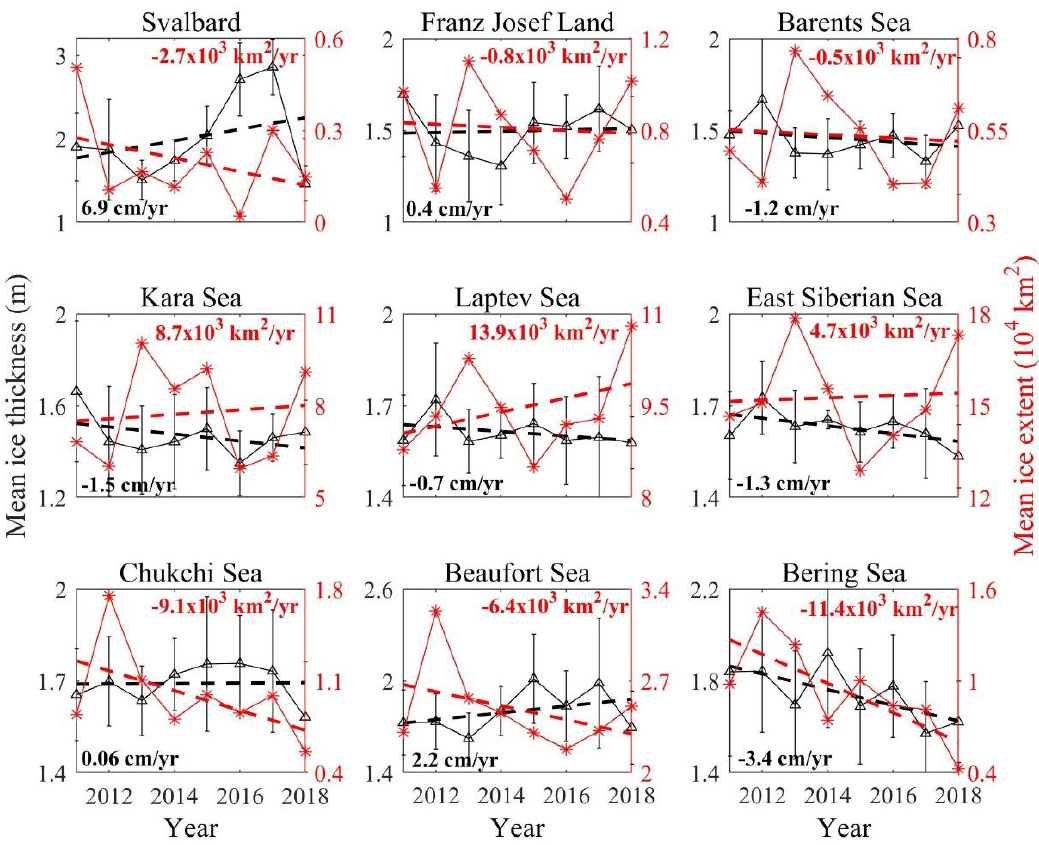
Figure 9. The January–April mean landfast ice thickness for the nine subregions (black triangles) and its linear trend (black dashed line) during 2011–2018. The red stars and dashed line represented the annual mean landfast ice extent and its linear trend for the corresponding period.